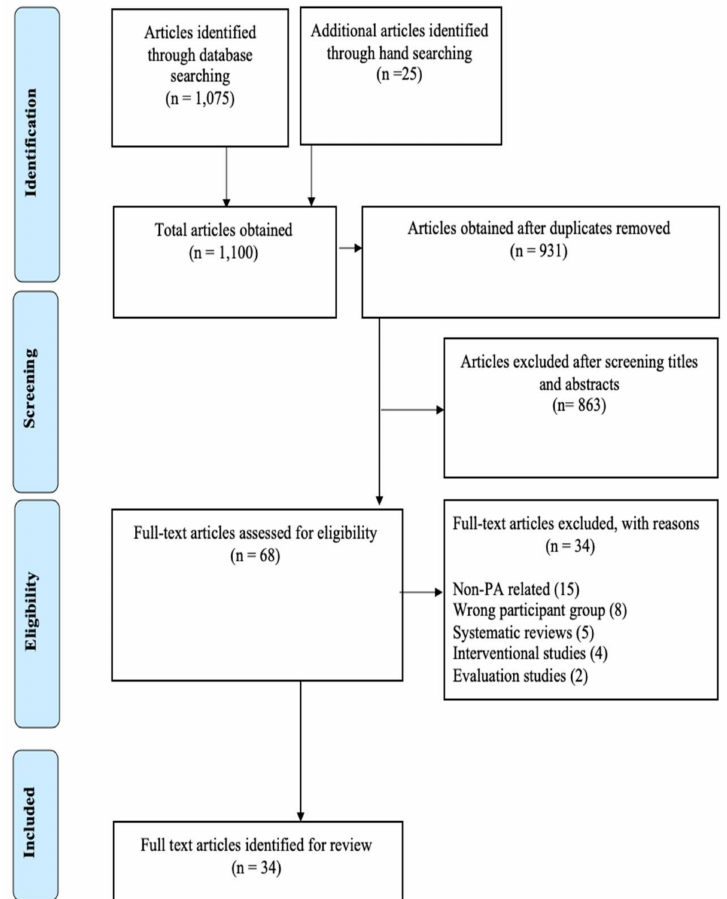
Figure 1. Flow chart of the study selection